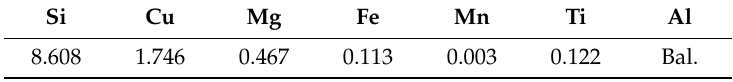
Table 1. The average value of the Secondary Dendrite Arm Spacing (SDAS) and aspect ratio of eutectic silicon particles were calculated through optical microscopy (Axio Imager Optical Microscope: Zeiss, Oberkochen, Germany) by image analyses. Table 1. Chemical composition (wt.%) of A354 alloy measured on the castings by GDOES. Si Cu Mg Fe Mn Ti